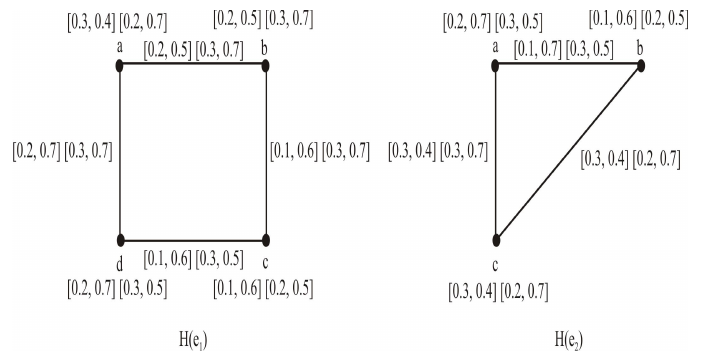
Figure 1: SIVPFSGs ˇ G